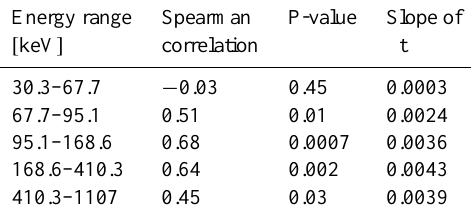
Table 4. Spearman correlation coefficients between differential pro- ton fluxes in the exterior cusp and substorm activity (AE index) in different energy